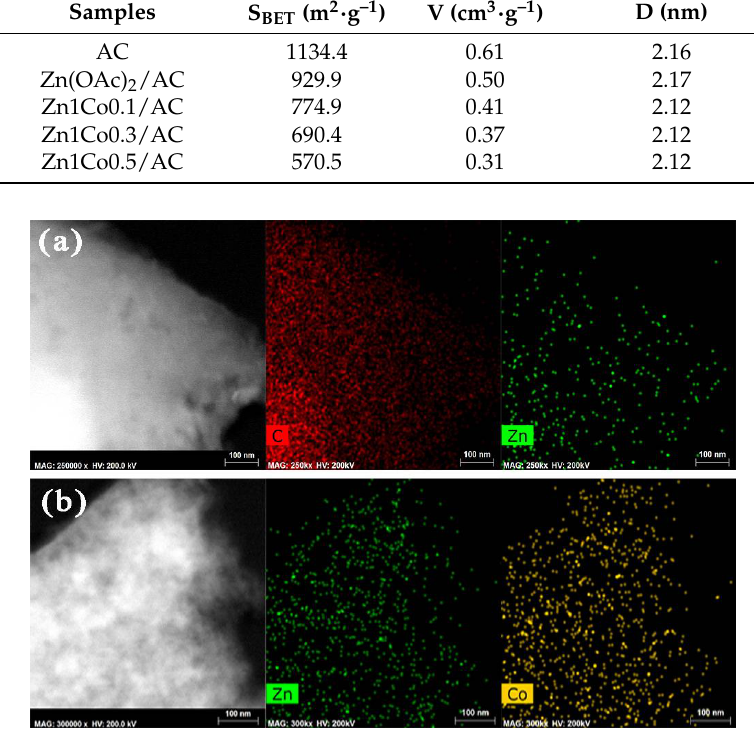
Figure 2. TEM-mapping images of fresh catalysts: Zn(OAc) 2 /AC ( a ) and Zn1Co0.3/AC ( b ).